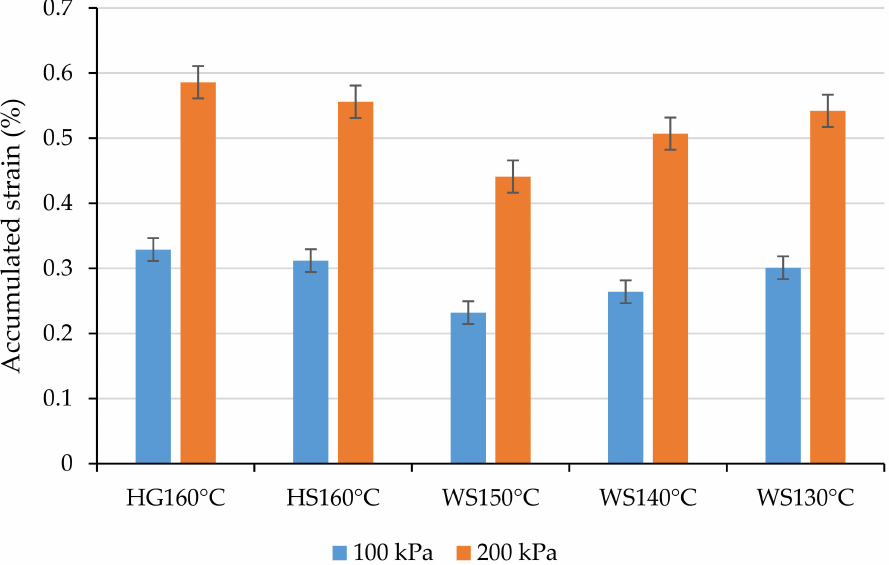
Figure 5. Accumulated strain and the standard error bars of the asphalt